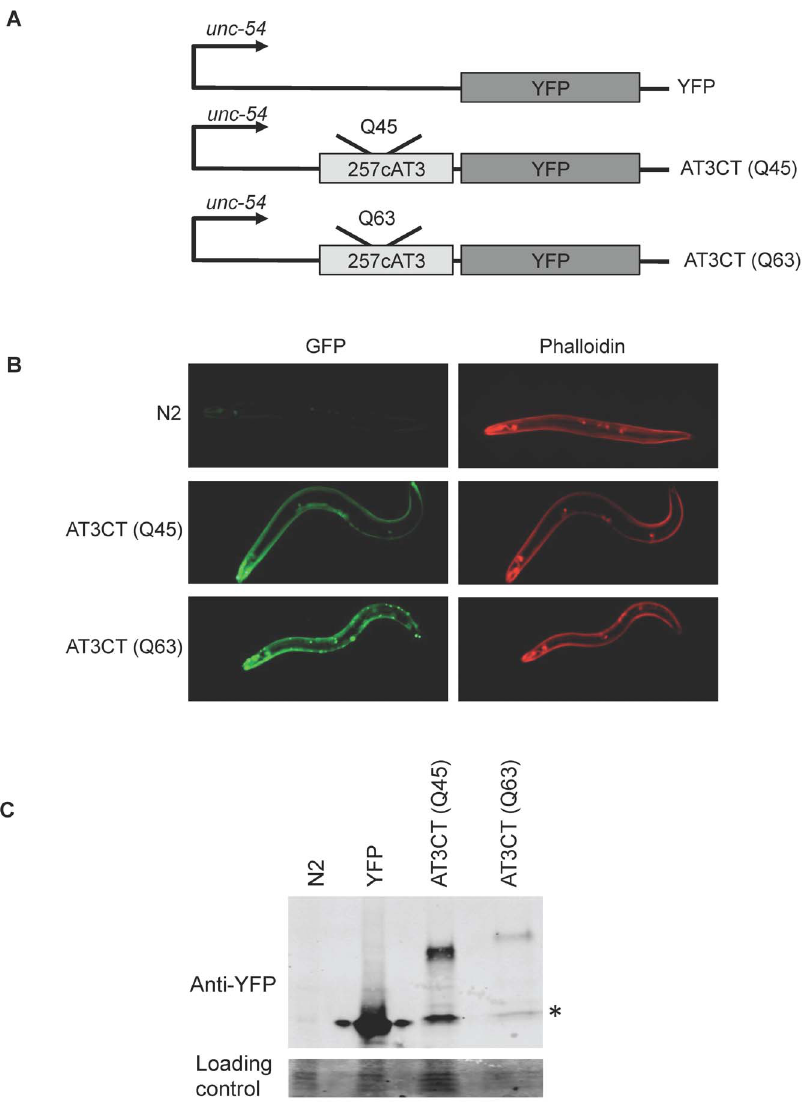
Figure 1. Expression of polyQ-expanded AT3CT in C.elegans body wall muscle cells. A. Schematic representations of gene constructs. The polyQ-containing C-terminal domain (lacking the N-terminal 257 amino acids) of AT3 was fused to YFP and expressed in body wall muscle cells under the control of the unc-54 promoter to generate P unc-54 257cAT3(Q n )::YFP, herein referred to as AT3CT(Q n ) B. Fluorescent micrographs showing fixed N2 (wild type), AT3CT(Q45), and AT3CT(Q63) animals imaged for YFP fluorescence (green) or phalloidin-stained actin filaments (red). C. Western blot with an anti-GFP antibody showing relative protein levels for C. elegans expressing YFP alone or AT3CT(Q45) or AT3CT(Q63). The asterisk (*) represents protein running as a GFP monomer. In the AT3CT (Q45) and AT3CT (Q63) lanes, these bands seem to represent cleavage fragments that are likely artifacts of protein extraction.